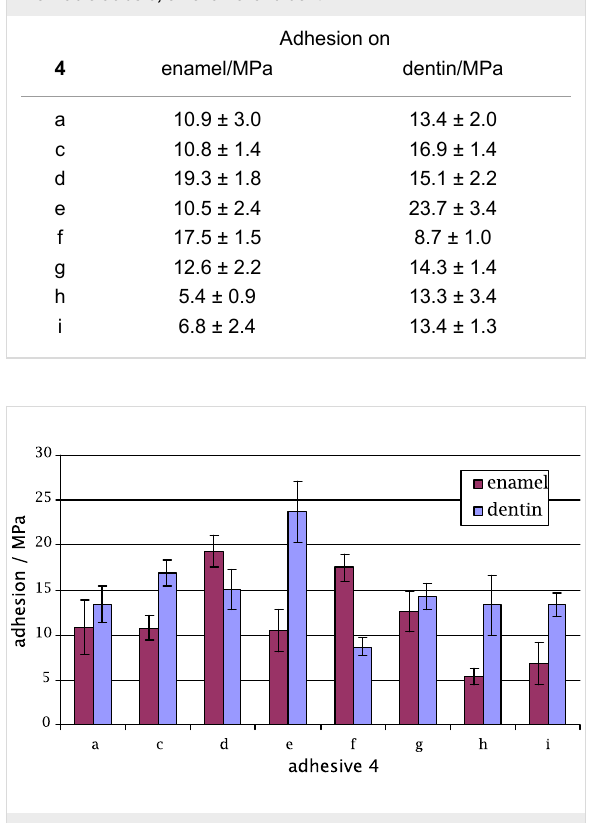
Figure 1: Adhesion of an adhesive composition 4, comprising of poly- merizable acids 3, on enamel and